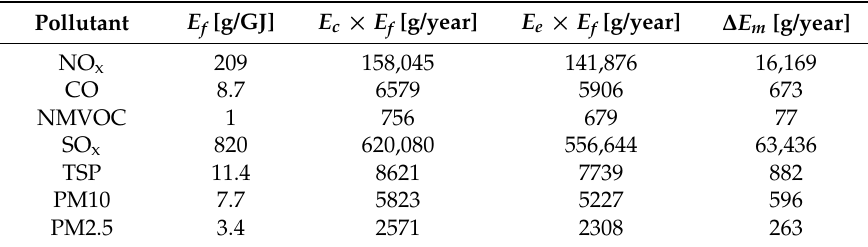
Table 2. The results of calculations for the reduction of pollutant emissions into the air as a result of the optimization of the cross-section shape of the thermal